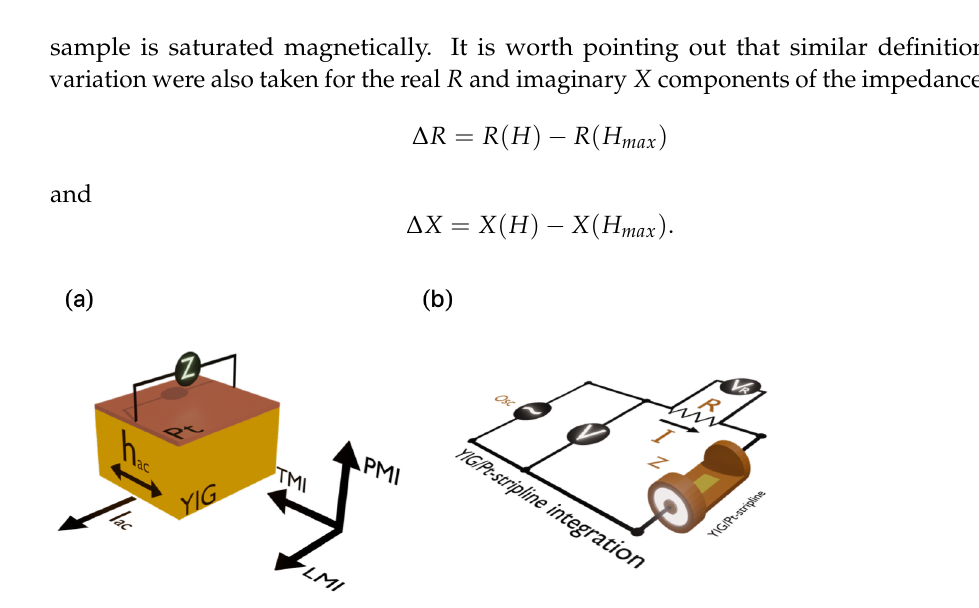
Figure 1. Schematic representation of the MI experiments. ( a ) LMI, TMI, and PMI setups employed in the dynamic magnetic characterization. ( b ) YIG/Pt-stripline system integrated in a circuit as a MI-sensor element.